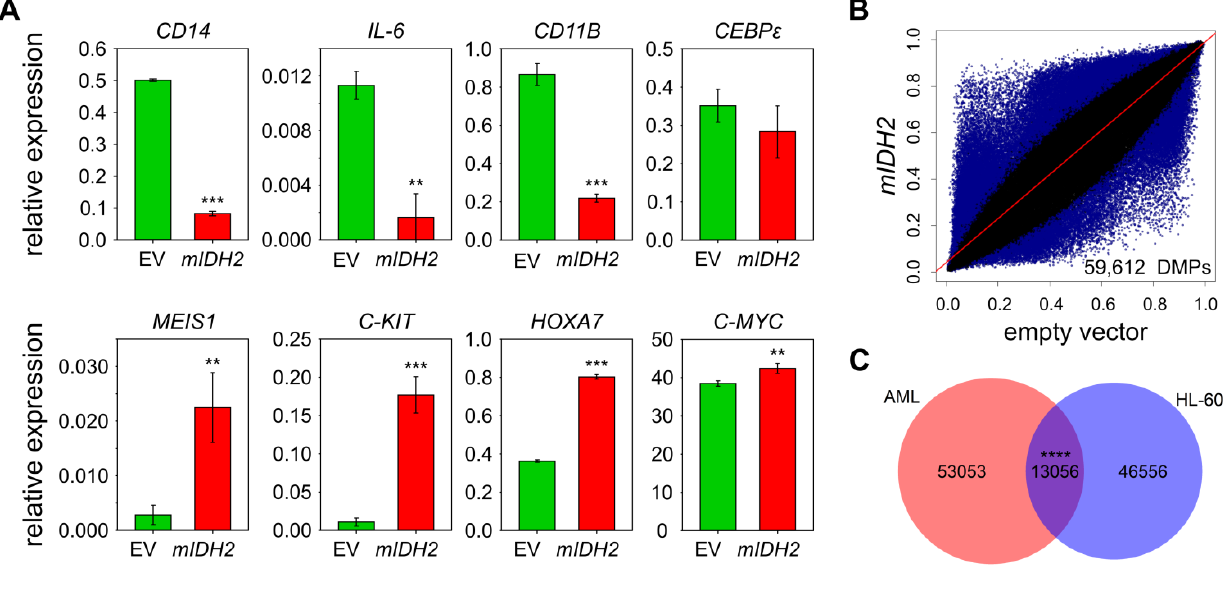
FIGURE 2: Genomic methylation profiles of mIDH AML patients and HL-60 cells expressing IDH2 R140Q are distinct. (A) Expression analysis of myeloid progenitor and differentiation genes by qRT-PCR in HL-60 cells transduced with empty vector (EV) or mIDH2. Expression is shown relative to ACTB transcript levels. Error bars indicate standard deviation (n=3). Statistical significance was calculated using a two-sided Stu- dent's t -test (*** P <0.001, ** P <0.01). (B) Scatterplots comparing average beta values for all probes common to 450K and EPIC chip between HL-60 cells transduced with mIDH2 or empty vector. Each dot represents one probe with DMPs colored in blue. Two biological replicates were analyzed independently on the 450K chip per condition. (C) Venn diagram showing the overlap between DMPs found upon presence of mIDH in the AML patient dataset and the HL-60 cells. The overlap between the two groups was minor, but greater than expected by chance using the hypergeometric test (**** P